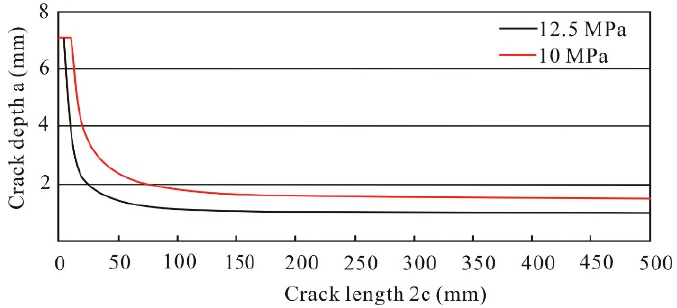
Figure 16. Failure-assessment diagram .